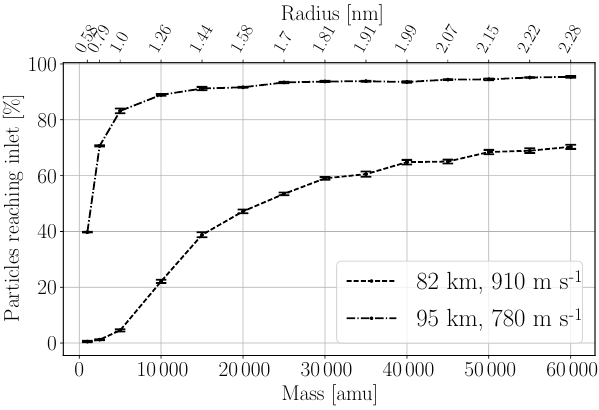
Figure 3. Simulated probabilities that particles reach the PD inlet (outer grid) as a function of mass (radius) for 82 and 95km. The velocity and background atmosphere correspond to WADIS-2 flight conditions. The statistics was derived from 4000 particle trajectories keeping the statistical error <